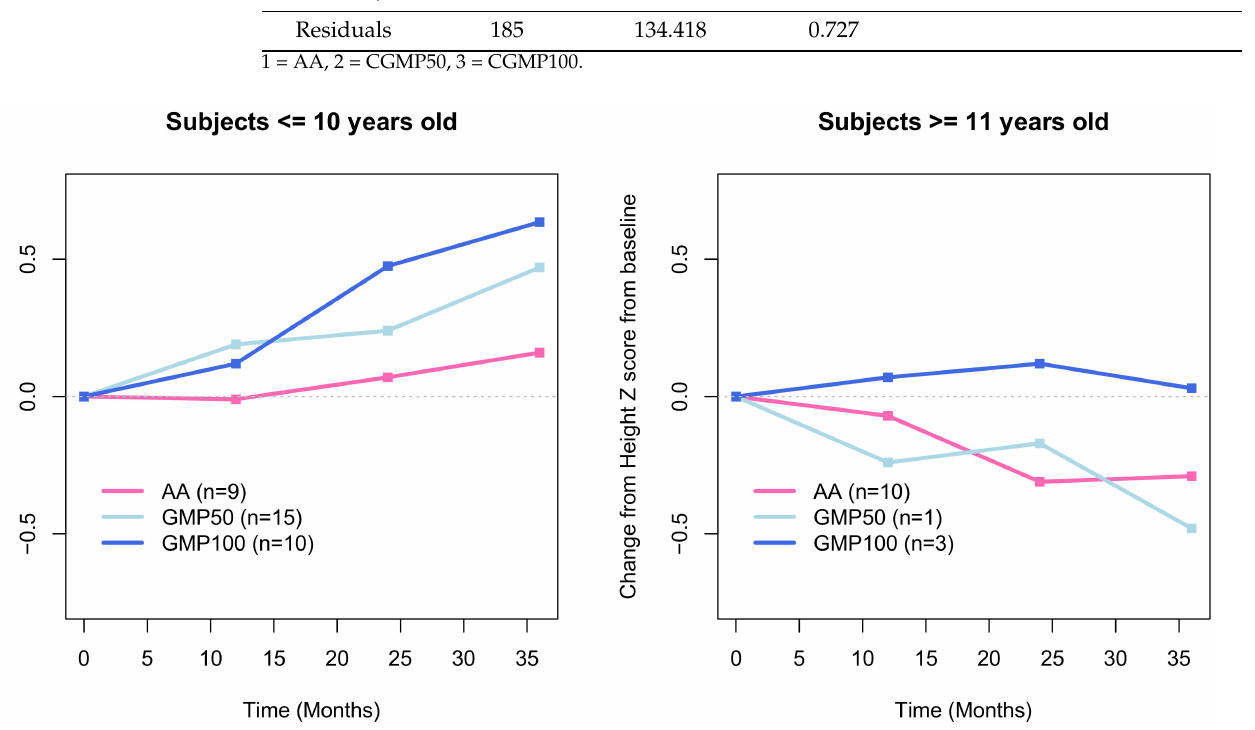
Figure 1. Change in median height z score from baseline to 36 months in the amino acids (AA), GCMP100 and CGMP 50 groups. Legend: AA, amino acid; CGMP, glycomacropeptide; CGMP50, protein substitutes based on combined CGMP and AA; CGMP100, protein substitute based on CGMP